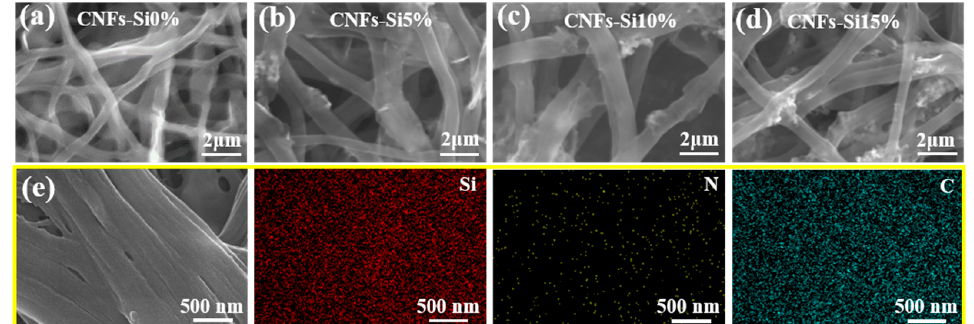
Figure 4. SEM images of ( a ) CNFs-Si0%, ( b ) CNFs-Si5%, ( c ) CNFs-Si10% and ( d ) CNFs-Si15%. ( e ) SEM image and the corresponding EDS mapping of Si, C, and N elements in partial CNFs-Si10%. Nitrogen adsorption–desorption curves of CNFs-Si0%, CNFs-Si5%, CNFs-Si10% and CNFs-Si15% are shown in Figure 5a. When P/P 0 > 0.4, a hysteresis loop appears in the nitrogen adsorption–desorption curves of all samples, which belong to the IV